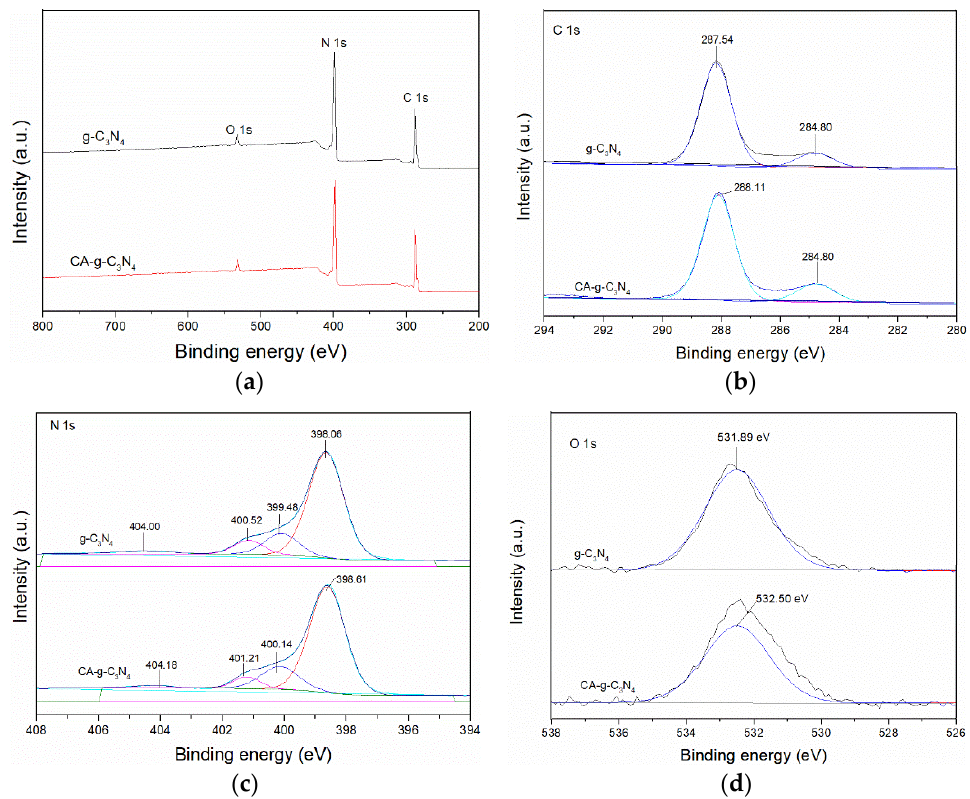
Figure 3. XPS of g-C 3 N 4 and CA-g-C 3 N 4 : ( a ) survey, ( b ) C 1s, ( c ) N 1s and ( d ) O 1s.